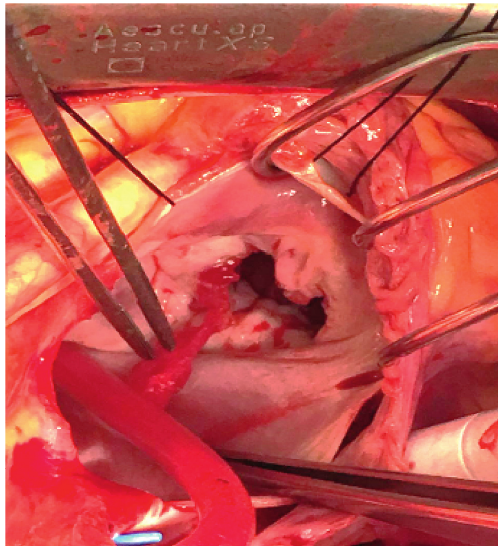
Figure 7: Intraoperative view, removal of the